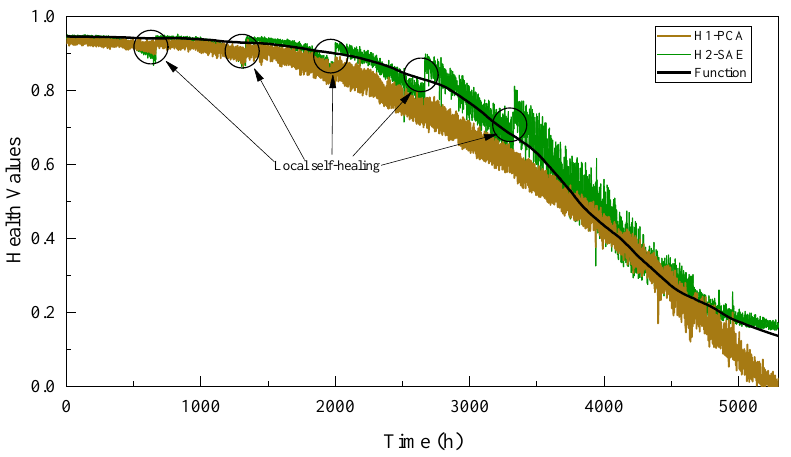
Figure 8. Fusion effect comparison.